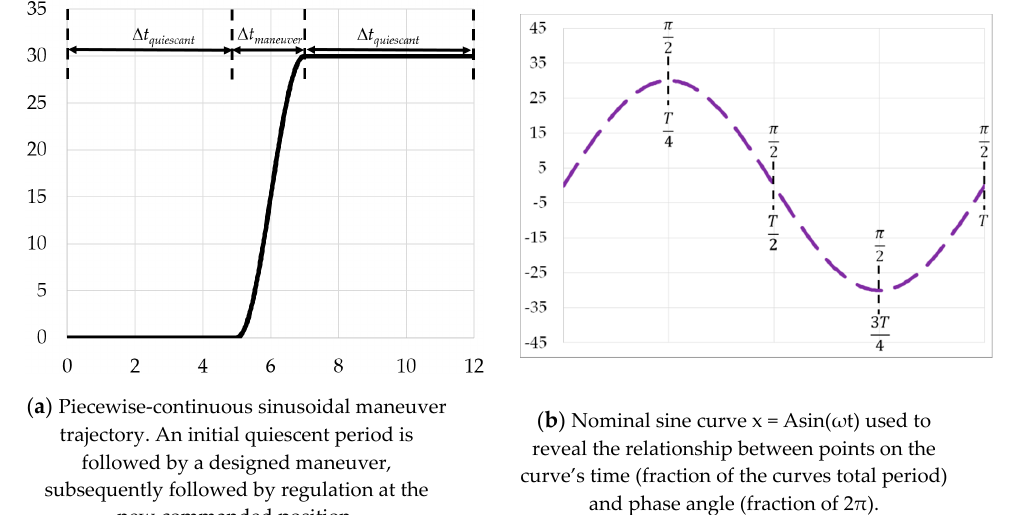
Figure 3. Creation of a piecewise-continuous sinusoidal maneuver trajectory autonomously generated to guarantee a specified maneuver time (to be provided by offline optimization).